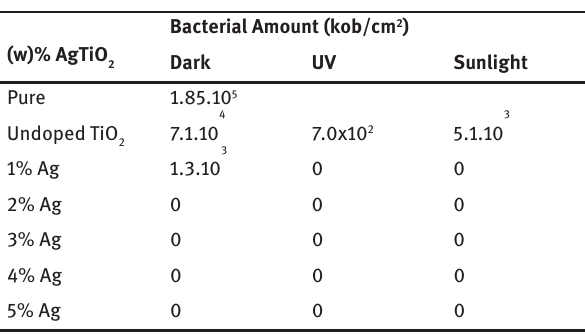
Table 3: Bacterial Amount (kob/cm 2 ). Bacterial Amount (kob/cm 2 ) (w)% AgTiO Dark UV Sunlight 2 Pure 1.85.10